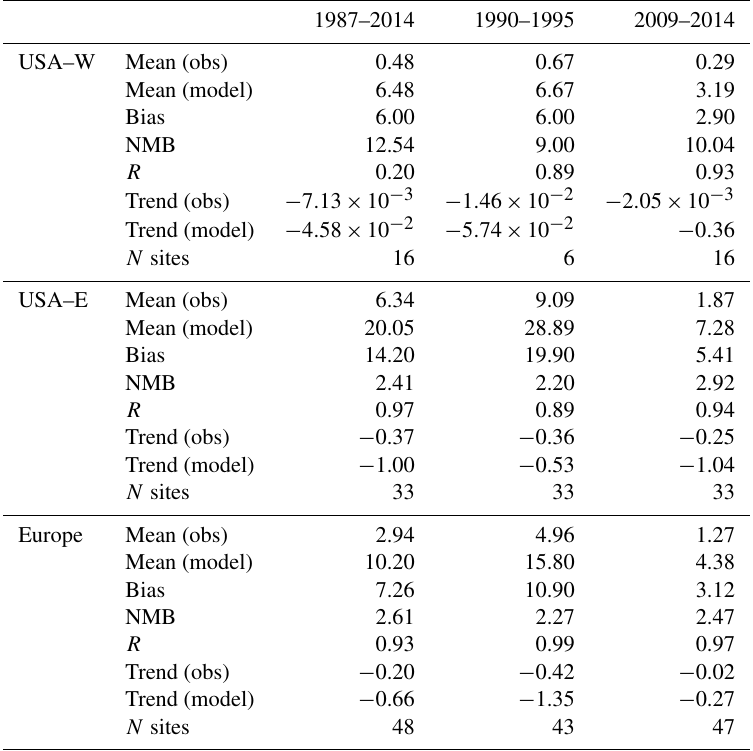
Table 3. Statistics for mean annual surface SO 2 concentrations at USA–W, USA–E, and Europe. The mean and trend values are in µgm − 3 and µgm − 3 yr − 1